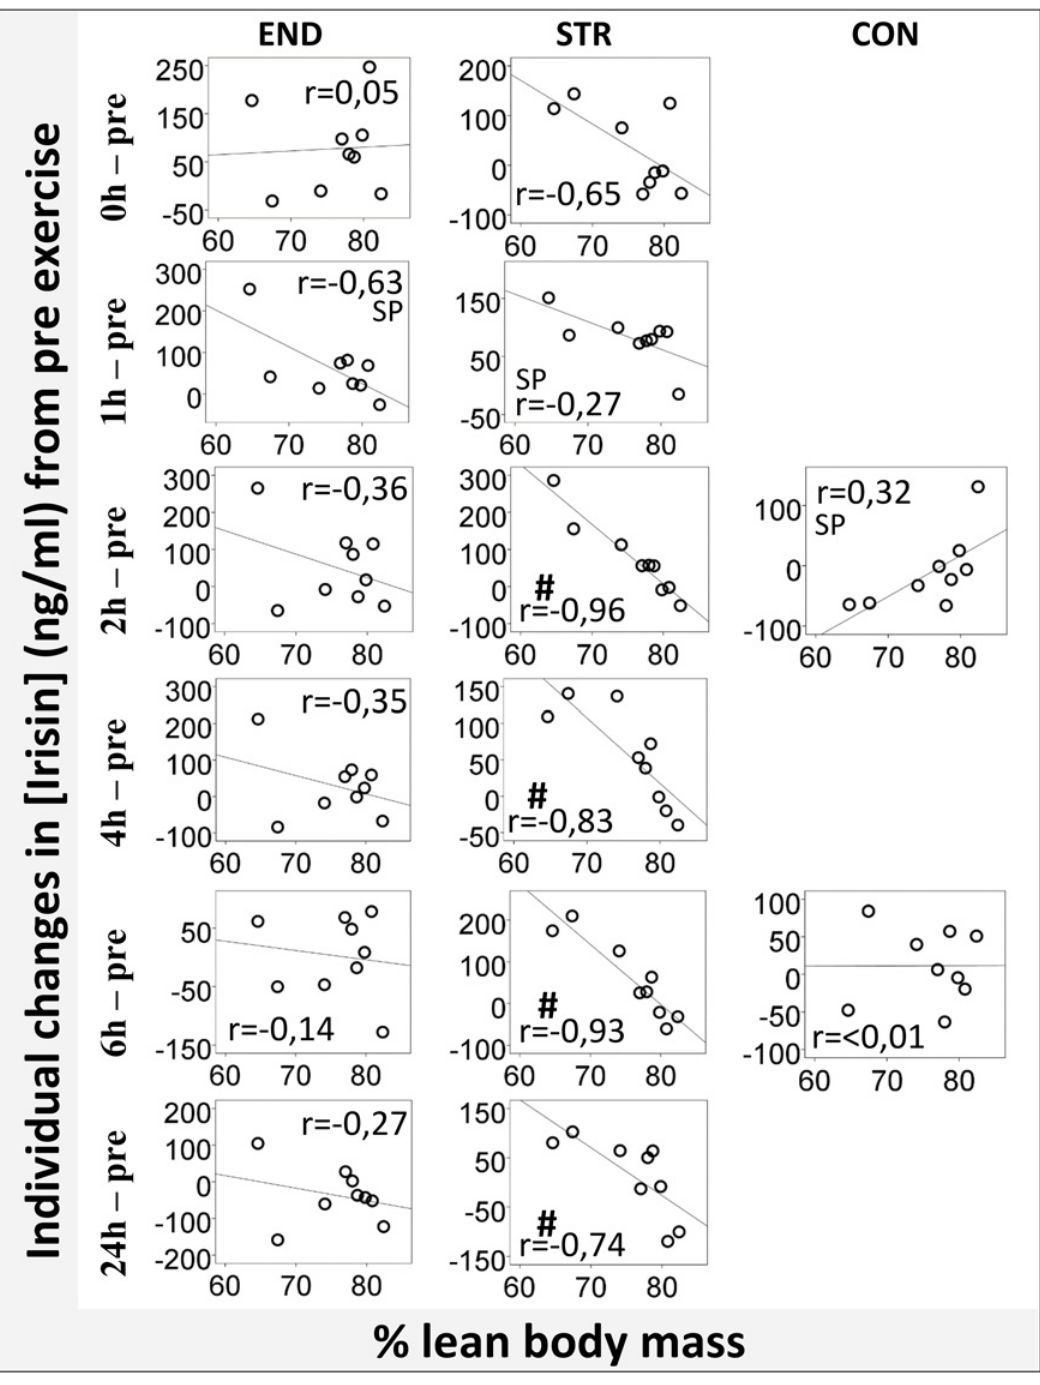
Fig 3. Lean body mass and exercise induced changes in irisin. Correlations between proportions of lean body mass and relative changes in plasma irisin following singular sessions of intense endurance exercise (END) or heavy strength training (STR), or on a control day (CON) without training. The X axis represent individual % lean body mass. The Y axis represent individual changes in irisin concentration from baseline to each of the different time points with blood samples. Correlation analyses were performed using Pearson ’ s method, except of the ones marked sp , which were performed using Spearman ’ s method due to a lack of normal distribution. # = p (cid:3)